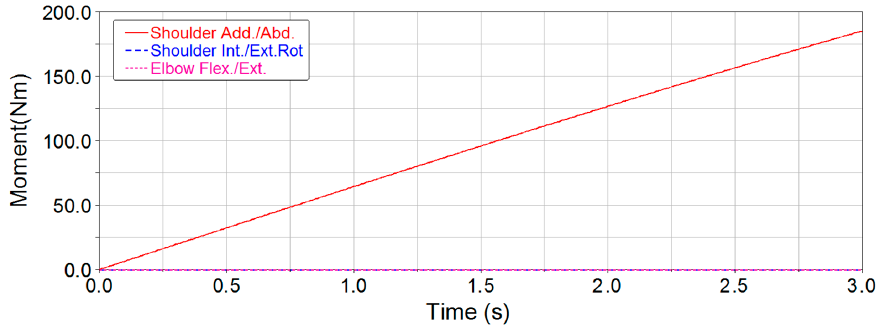
Figure 13. Joint torque curves of lateral lifting for the 5 ‐ DOF exoskeleton.